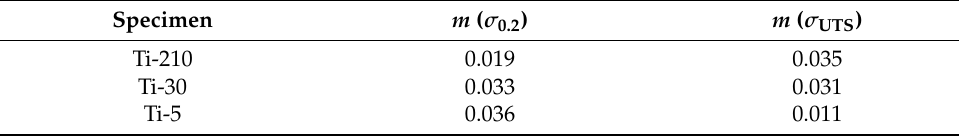
Table 3. Strain rate sensitivities of σ 0.2 and σ UTS